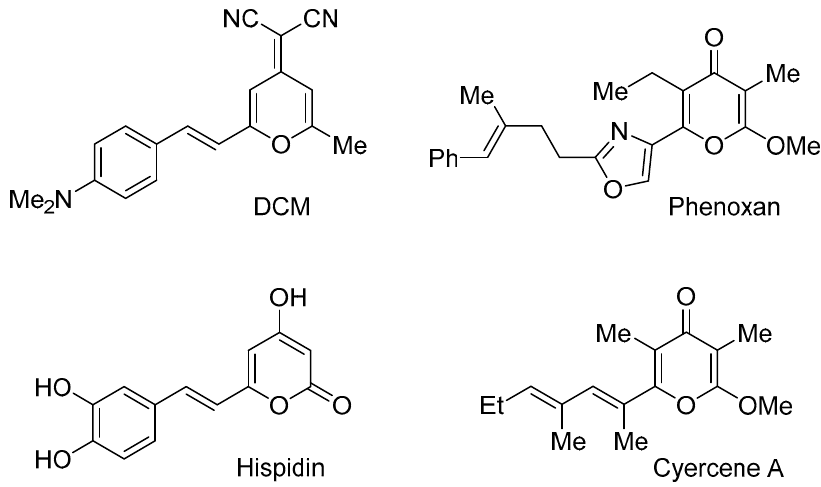
Figure 1. Some important 4-pyrones and their derivatives.